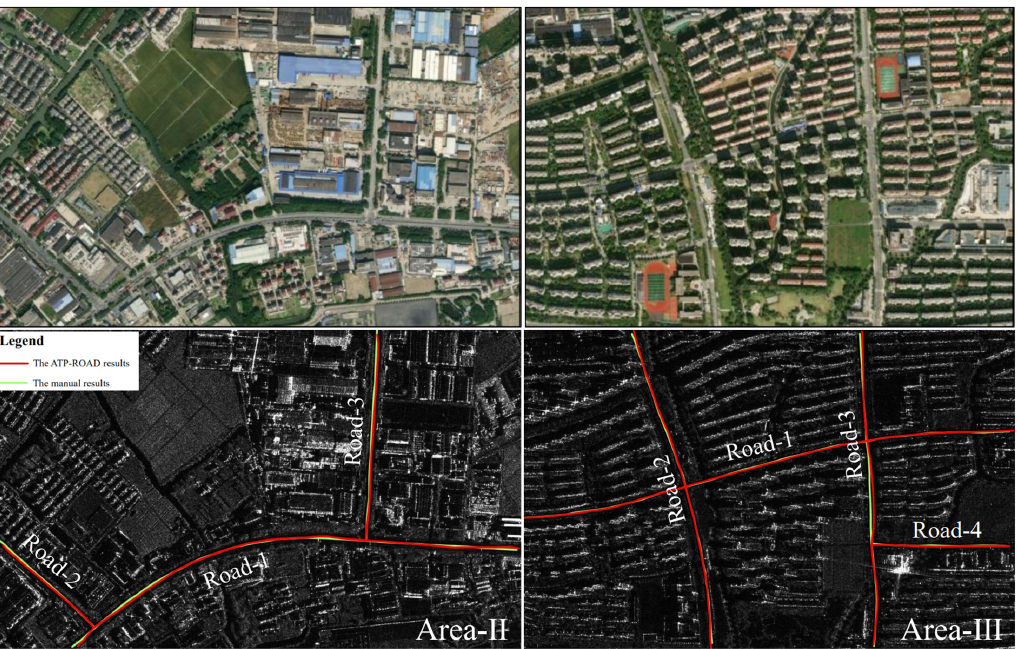
Figure 11. The extracted roads of both Area-II and Area-III with a comparison with the GeoEye multispectral images. Table 5. Assessment of the ATP-ROAD-extracted results for Area-II and Area-III using distance statistics.